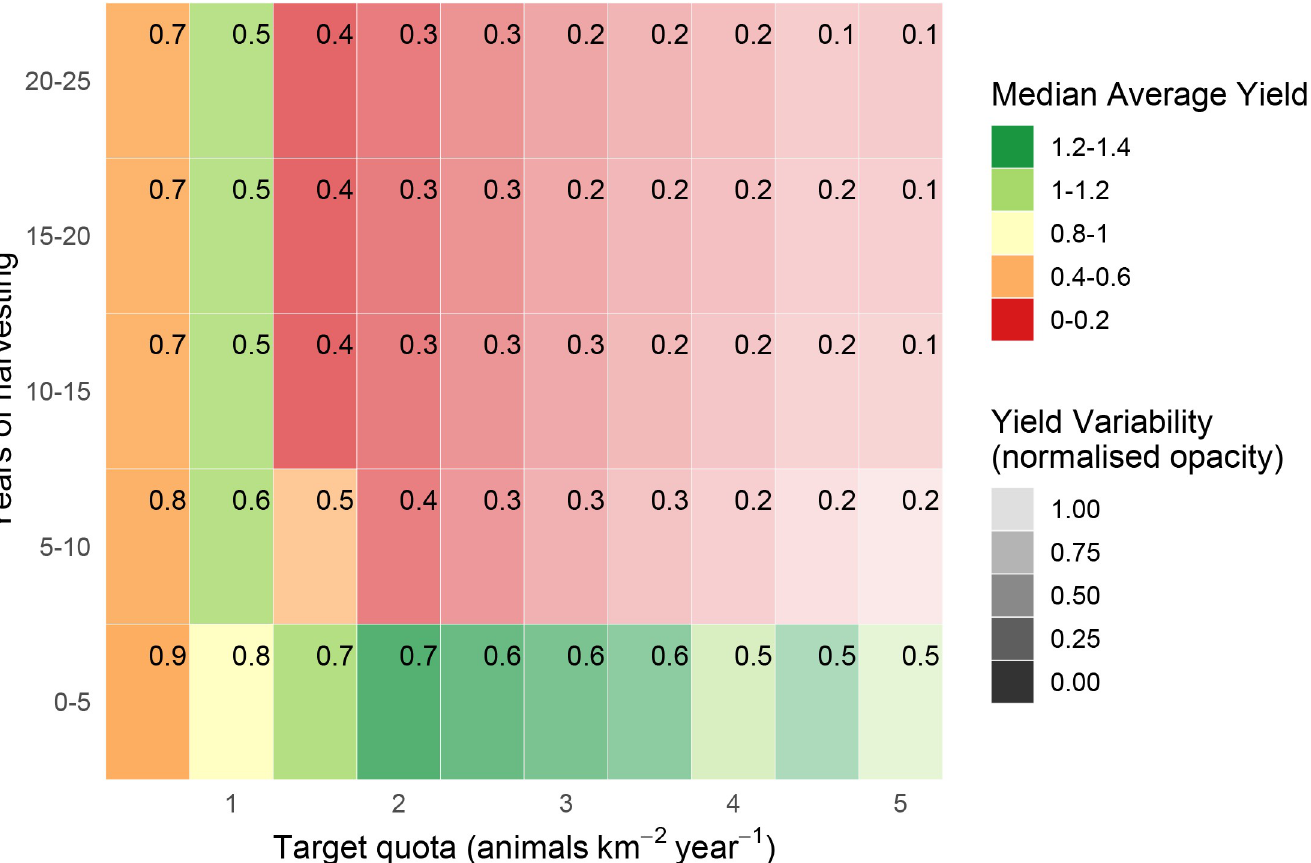
Fig 6. Estimated yields (animals km -2 year -1 ) from quota-based harvesting of Peters’ duiker C . callipygus . Yields are estimated in 5-year increments over 25 years, with parameter uncertainty, with corresponding survival probabilities (in top-right corner of each rectangle).